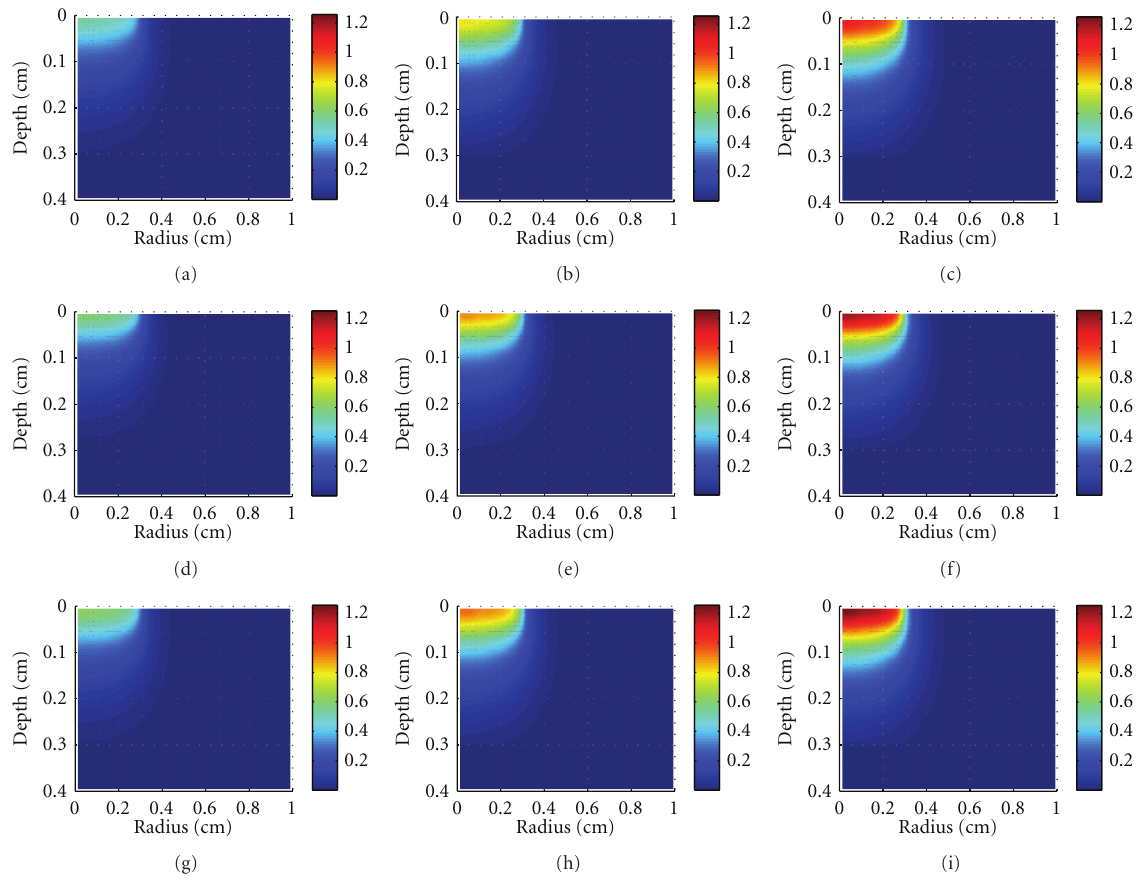
Figure 1: Optical absorption (J/cm 3 ) for nodular BCC tumor: (a) 100 mW/cm 2 , (b) 150mW/cm 2 (c) 200mW/cm 2 ; infiltrative BCC: (d) 100mW/cm 2 : (e) 150 mW/cm 2 , (f) 200mW/cm 2 ; SCC tumor: (g) 100 mW/cm 2 , (h) 150 mW/cm 2 , (i) 200 mW/cm 2 .